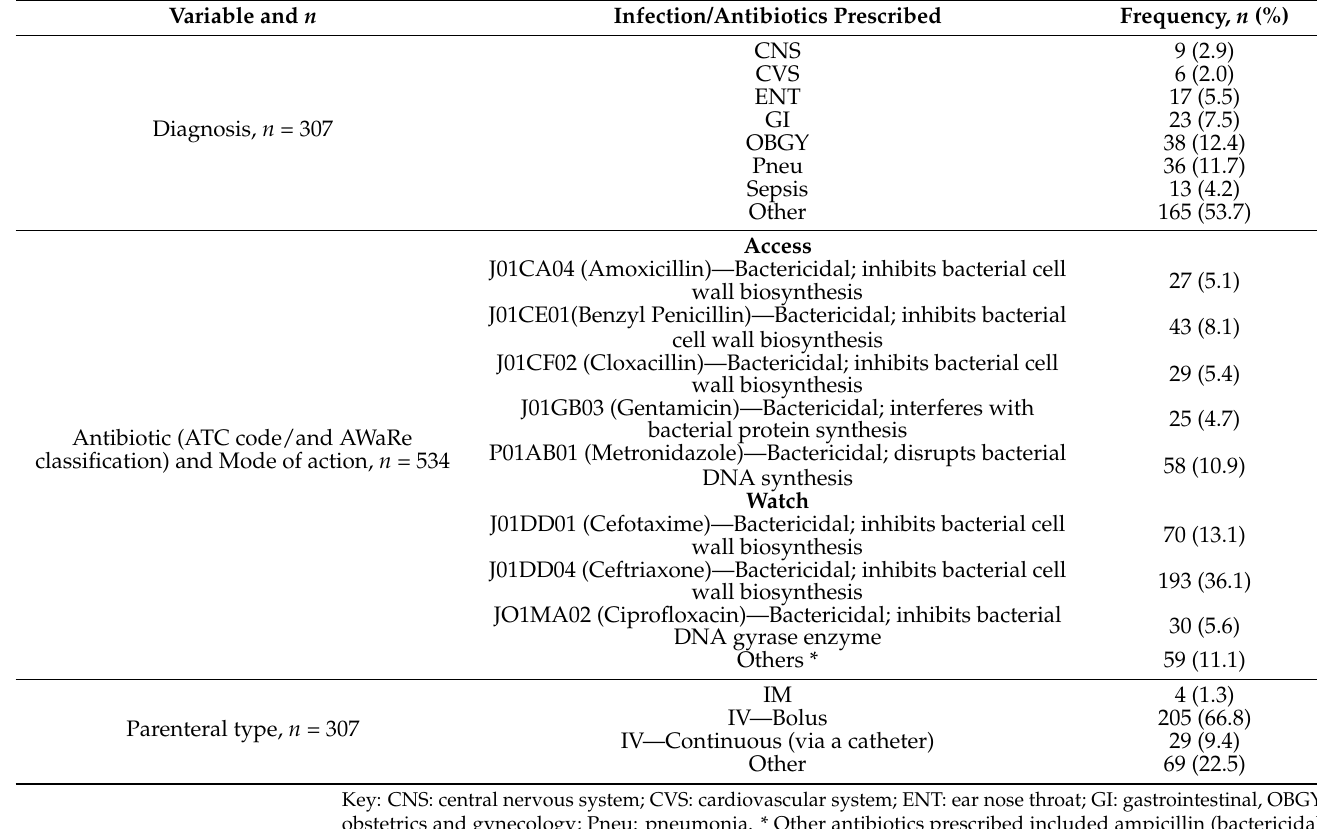
Table 2. Antibiotics prescribed, their mechanism of action, and common infections treated in the surveyed